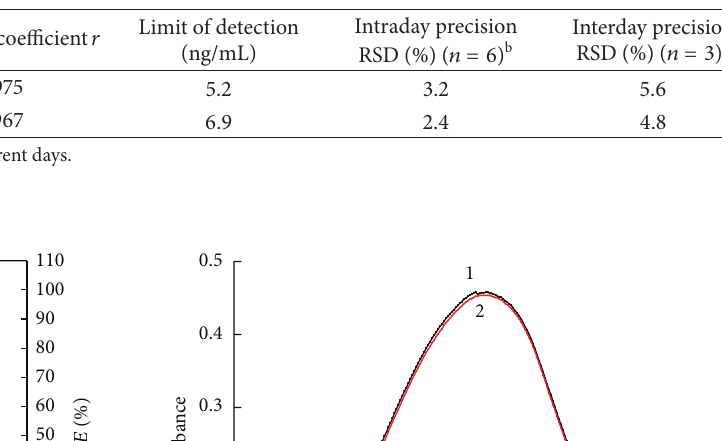
Table 1: Analytical figures of merit for Ta and SY using HPLC-UV method.